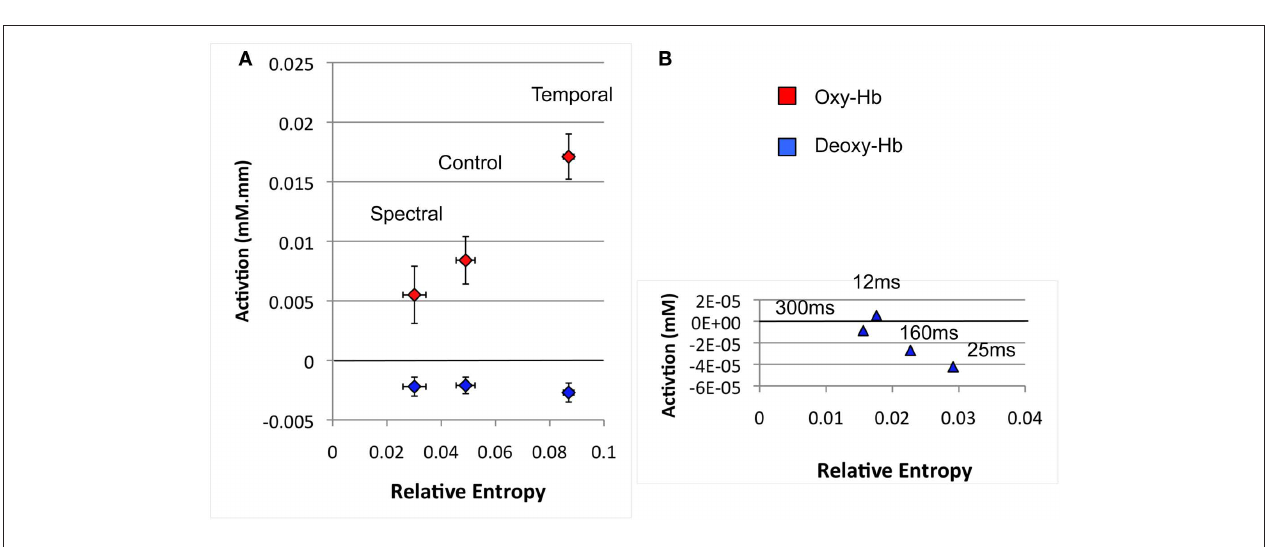
FiguRe 5 | average newborn brain activation in the perisylvian areas as a function of rate of change as measured by average Relative entropy for the stimuli. (a) Spectral, Control, and Temporal stimuli used in the present study (B) Stimuli used in Telkemeyer’s study (2009). The average activations